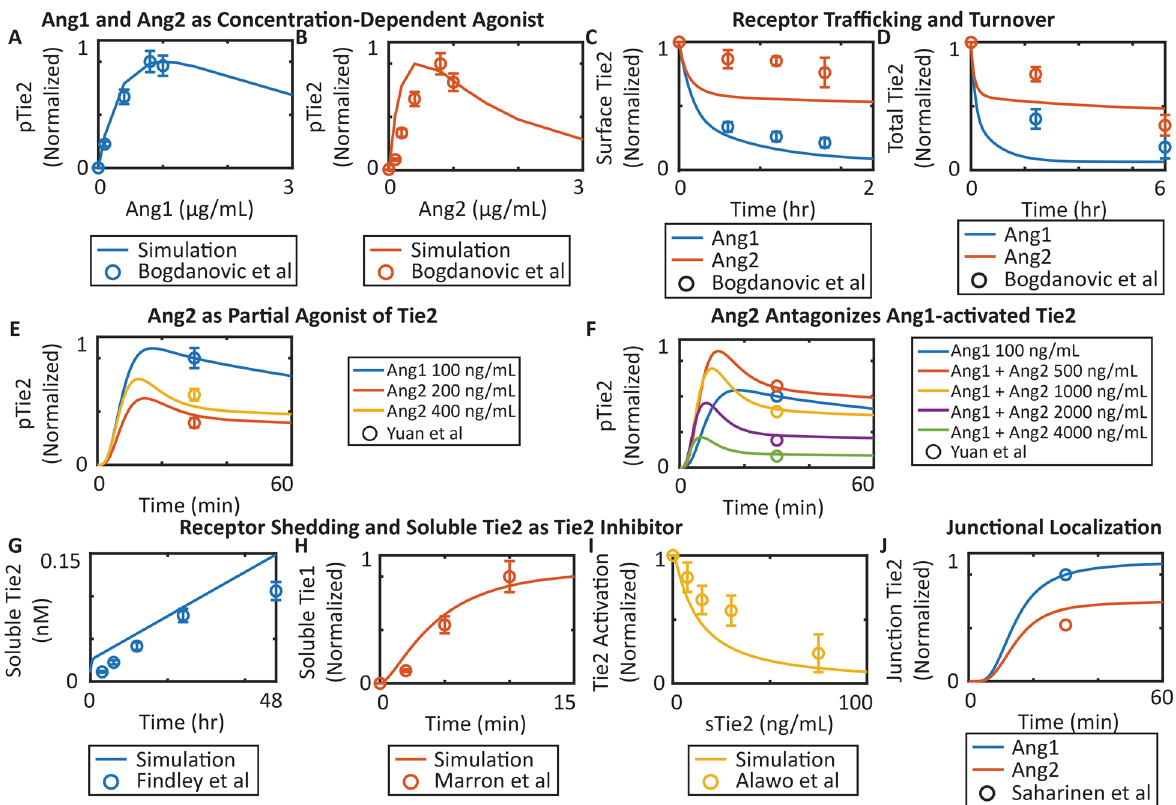
Fig. 2 Model calibration of ligand – receptor interactions and receptor dynamics using global optimization. A , B Ang1 and Ang2 are concentration-dependent agonizts of Tie2 (Bogdanovic et al. 70 ). C , D Ang1 and Ang2 induce receptor internalization and degradation of Tie2 (Bogdanovic et al. 70 ). E Ang2 is a weaker agonist compared to Ang1 (Yuan et al. 54 ). F Ang2 antagonizes Ang1-activated Tie2 at high concentrations (Yuan et al. 54 ). G , H Extracellular domains of Tie1 and Tie2 are constitutively cleaved from the surface of the cell (Findley et al. 35 , Marron et al 36 ). I Soluble Tie2 inhibits Tie2 activation in a concentration-dependent manner (Alawo et al. 51,71 ). J Ang1 and Ang2 induce junctional localization of Tie2 (Saharinen et al. 39